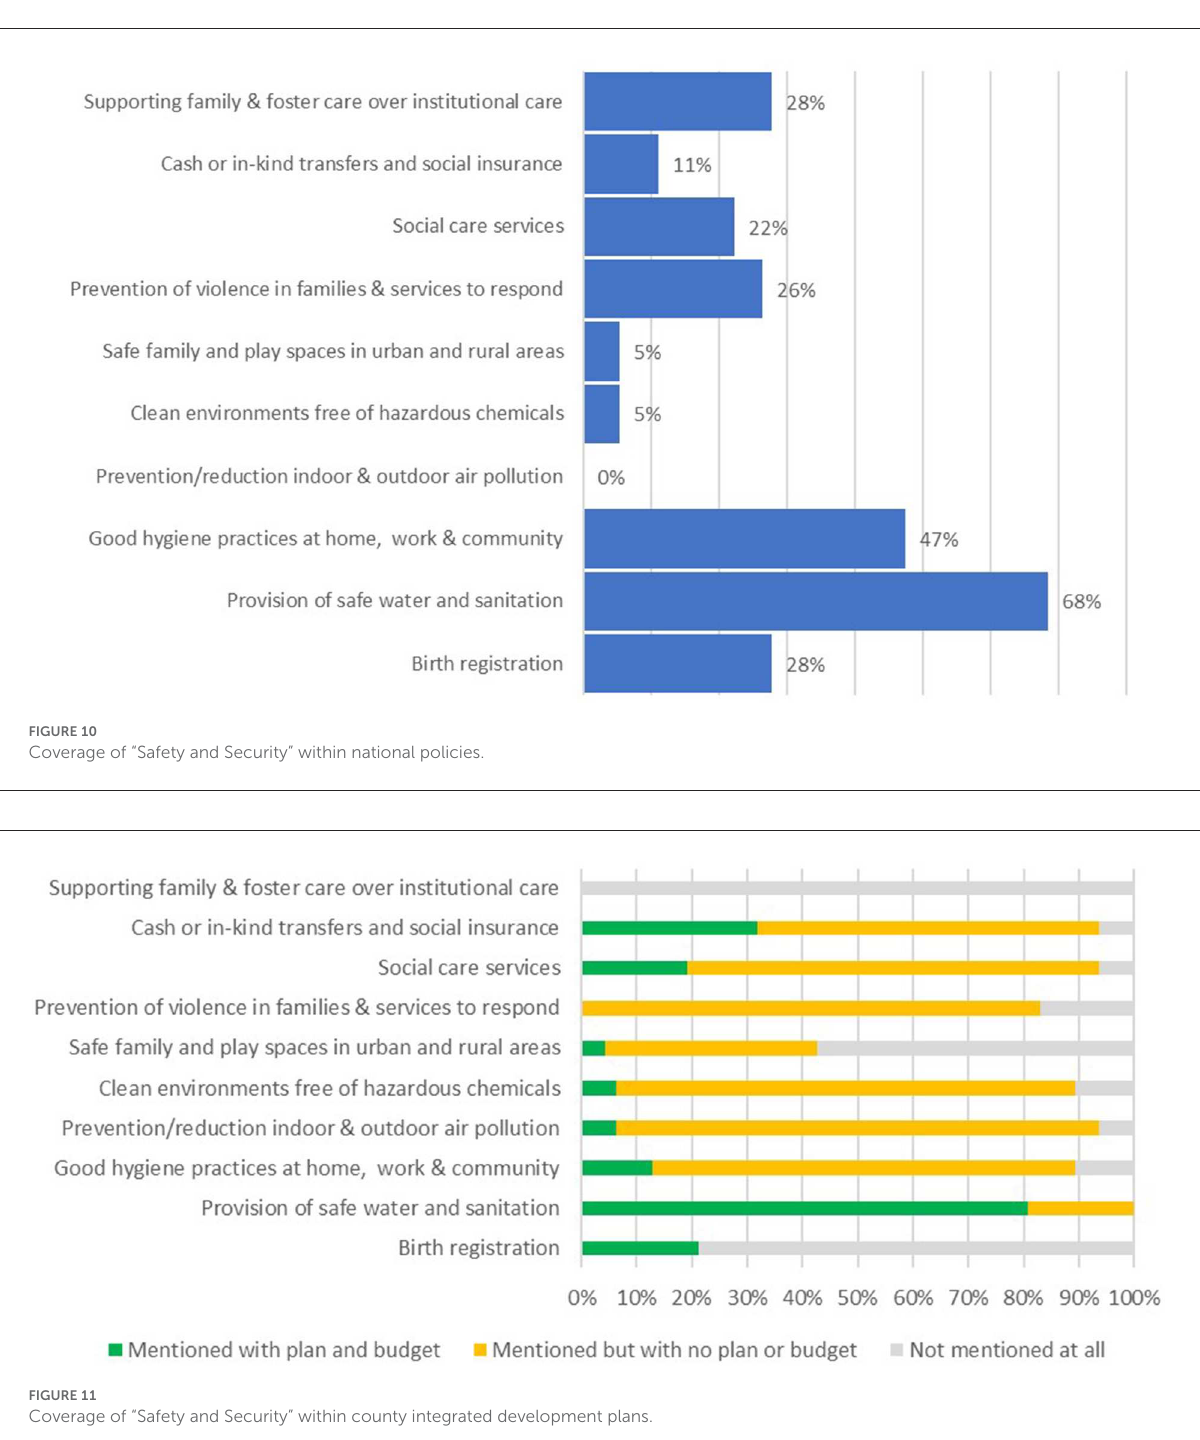
FIGURE11 Coverage of “Safety and Security” within county integrated development